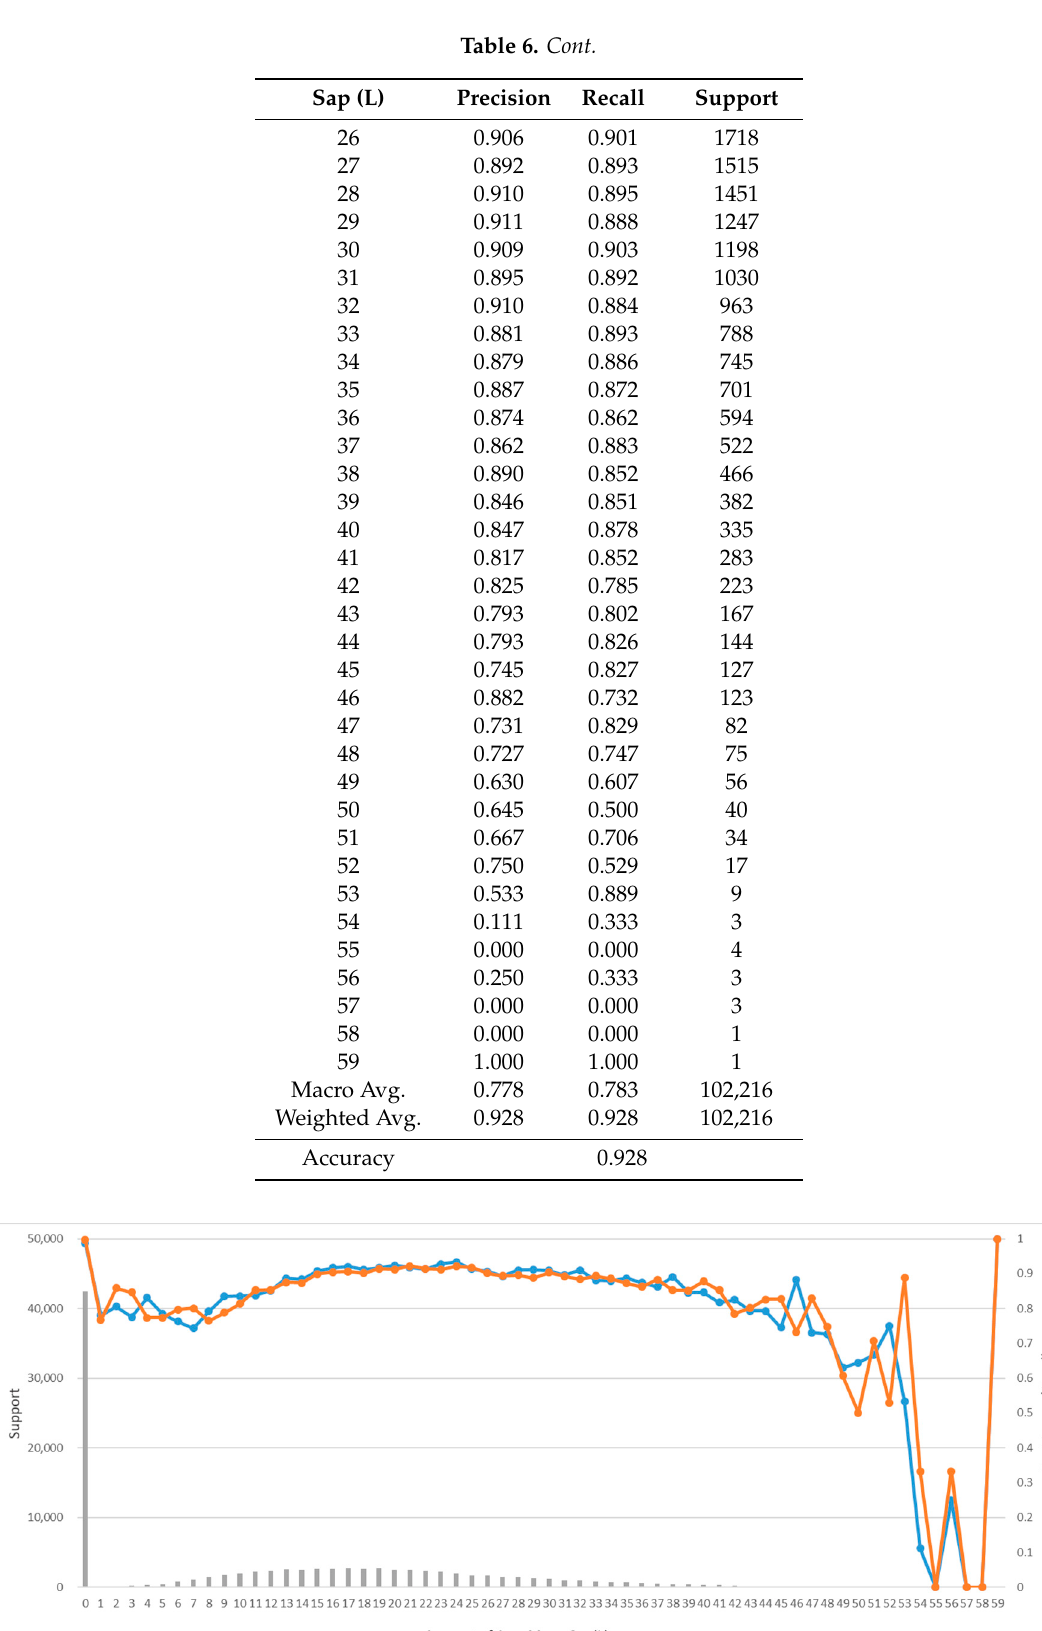
Figure 18. Prediction of sap amount based on SVM. 3.3.3. Artificial Neural Network Model ANN (artificial neural network) was chosen as a prediction model in the study since it could make an approximation function from the data used in learning and thus a proper Acer mono sap exudation prediction model. In the present study, ANN was embodied with TensorFlow. In the model, errors were reduced with a cross ‐ entropy function. With the activation function of ReLu (rectified linear unit), the learning rate was set at 0.001 in the learning process to predict the scope of Acer mono sap exudation [47–56].